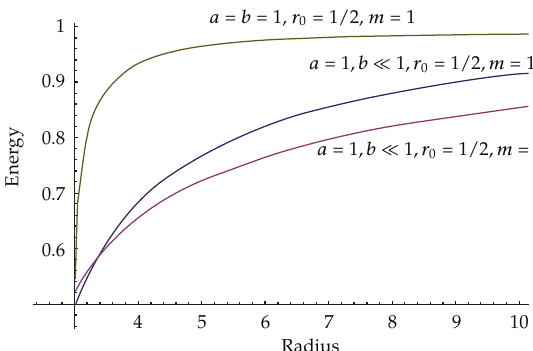
Figure 1: The plot for the M¨oller energy versus radius, in the case of the asymptotically flat black